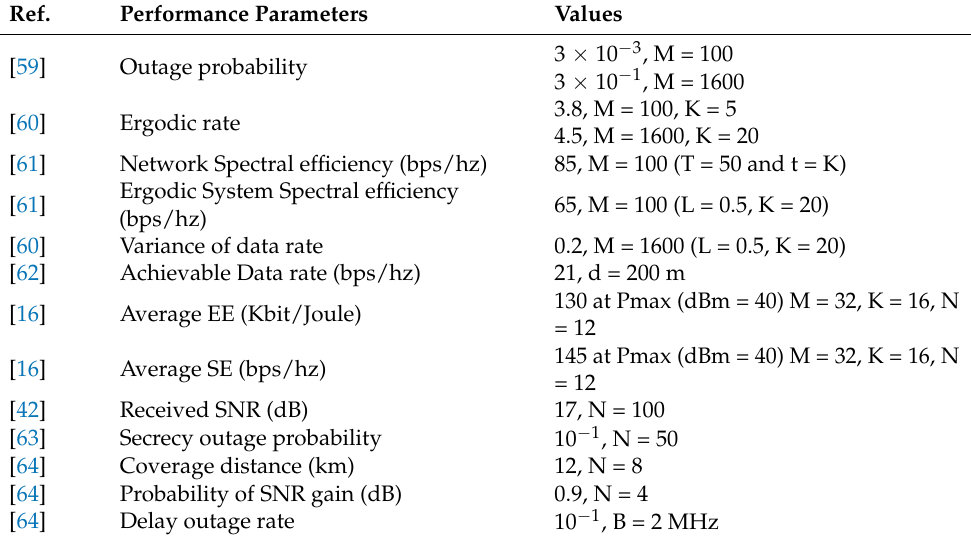
Table 3. RIS performance parameters comparison.